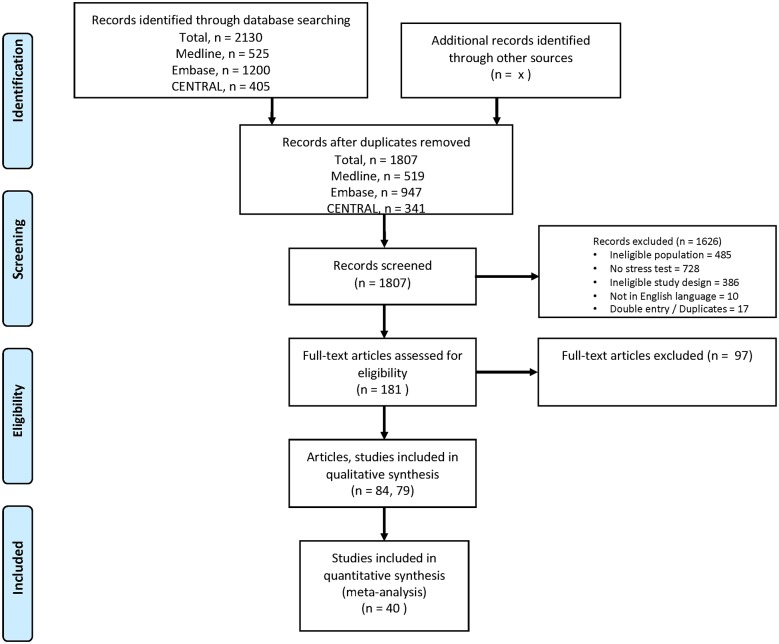
Flow chart.Adapted from: Moher D, Liberati A, Tetzlaff J, Altman DG, The PRISMA Group (2009). Preferred Reporting Iterns for Systematic Reviews and Meta-Analyses: The PRISMA Statement. PLoS Med 6(7): el000097. doi:10.1371/journal.pmedl000097. For more information, visit www.prisma-statement.org.